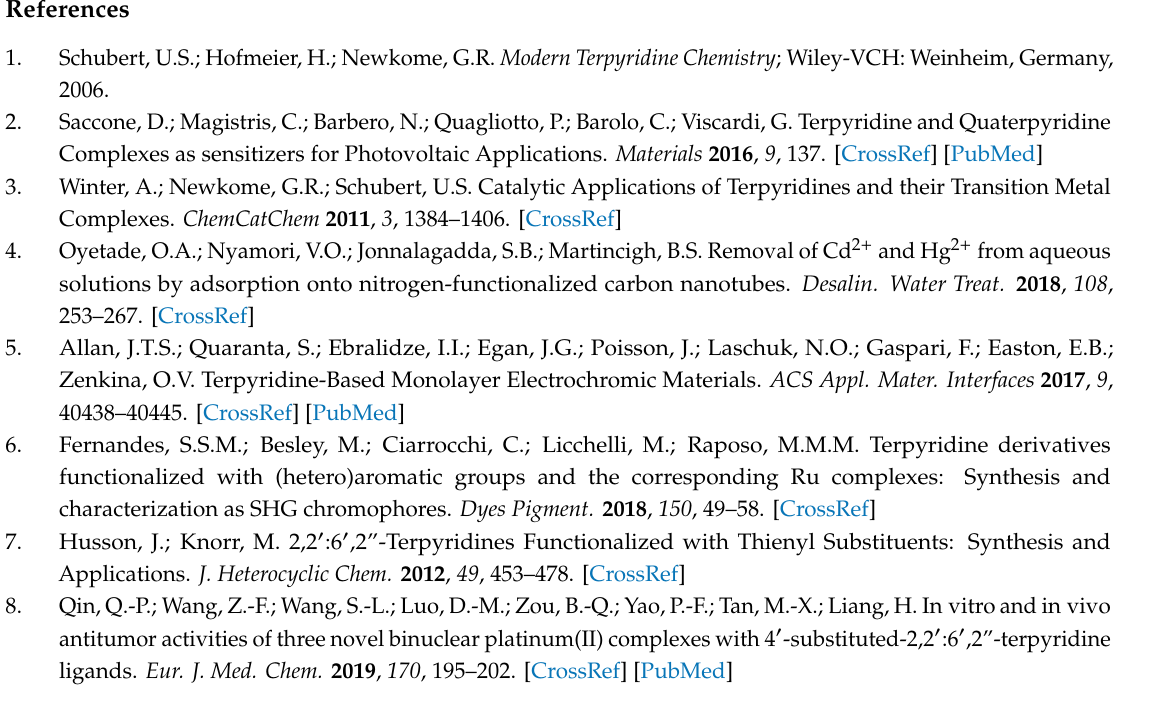
Figure S3: HR-MS of 1 , Figure S4: detailed molecular ion